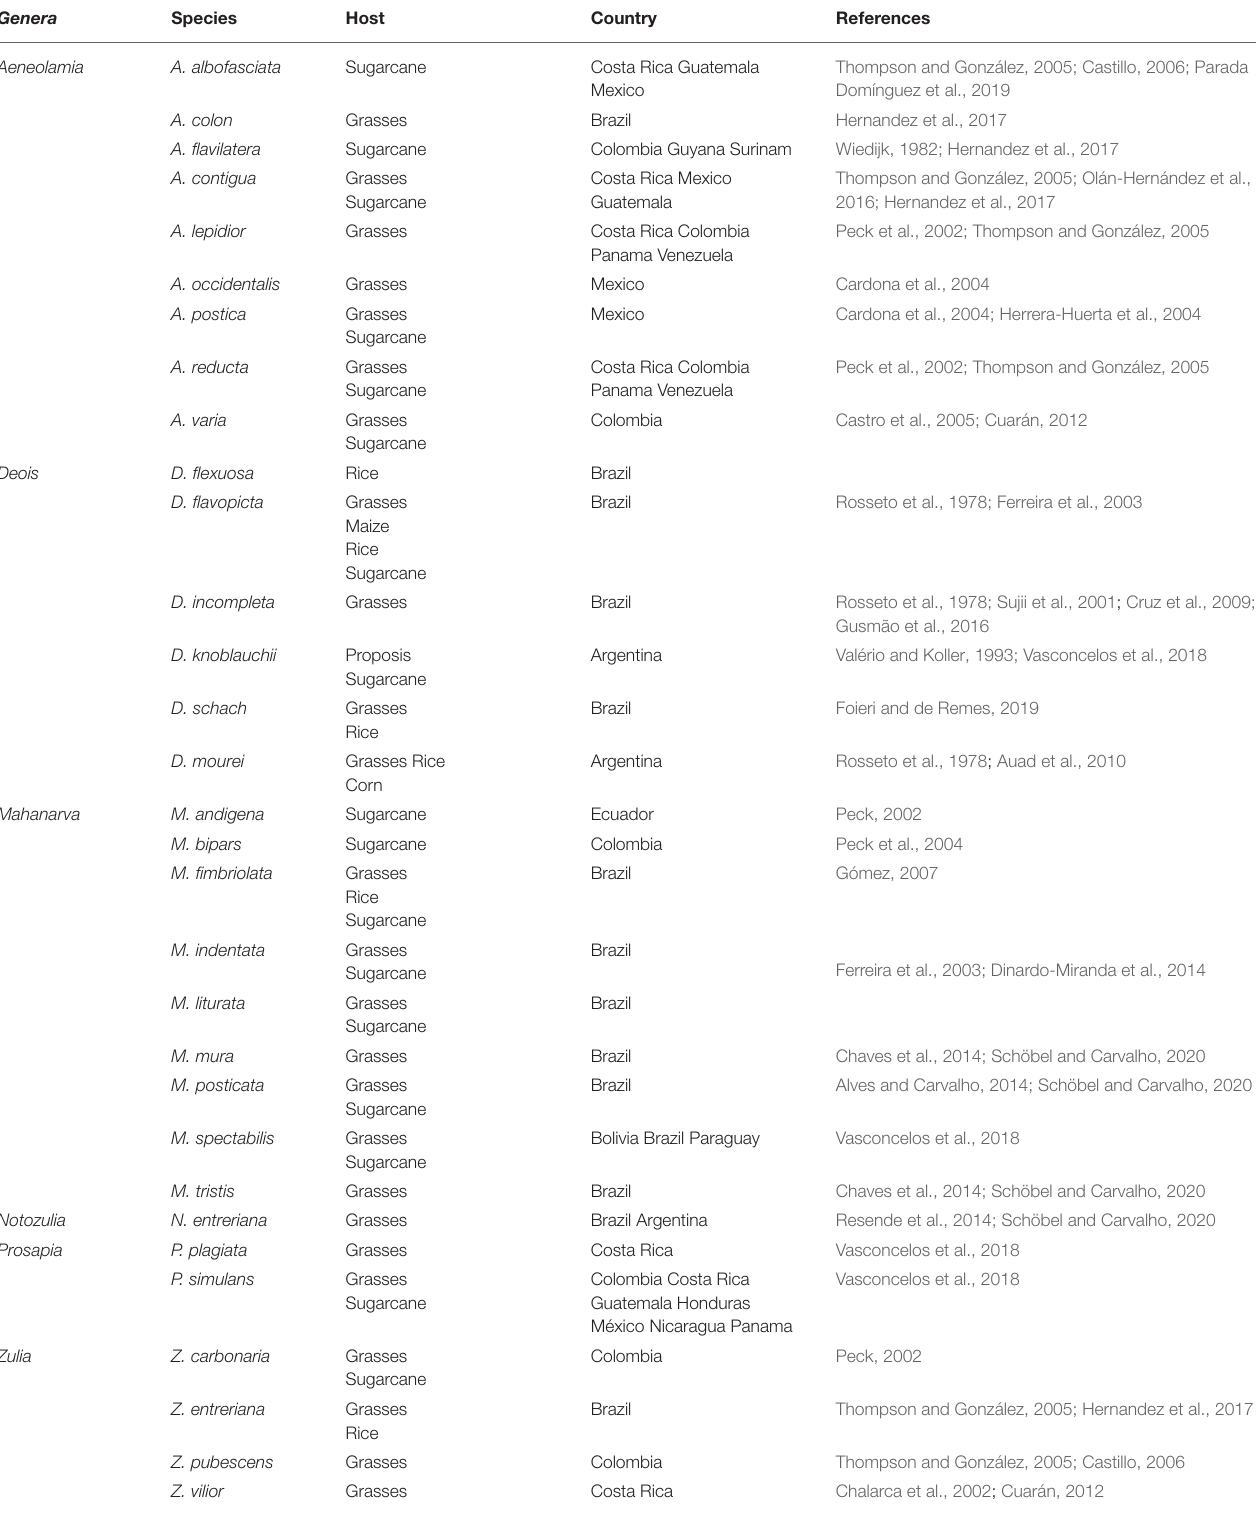
TABLE 1 | Reported economically important cercopid species in gramineous crops in the Neotropical ecozone.